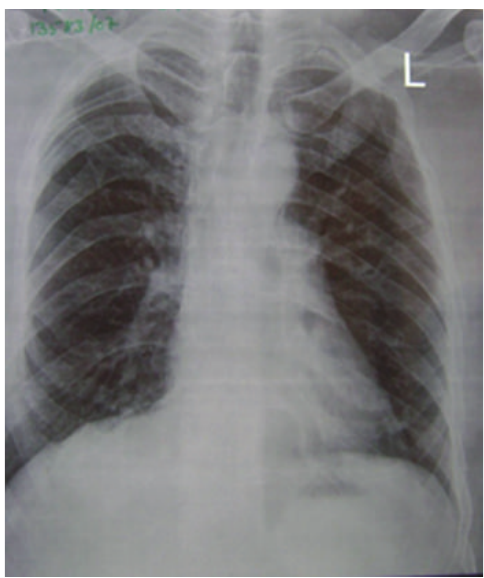
Figure 3: Bifid rib right 4th and 8th rib anteriorly.